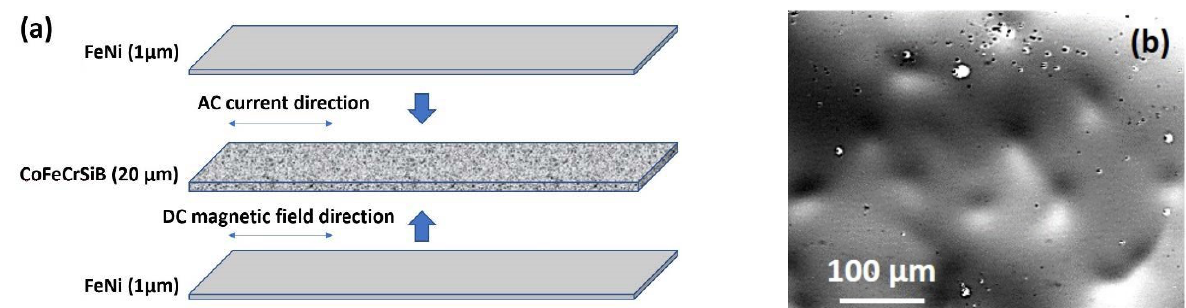
Figure 1. ( a ) Geometry of the model structure of FeNi/CoFeCrSiB/FeNi type. ( b ) Optical microscopy of the free surface of the amorphous CoFeCrSiB ribbon.